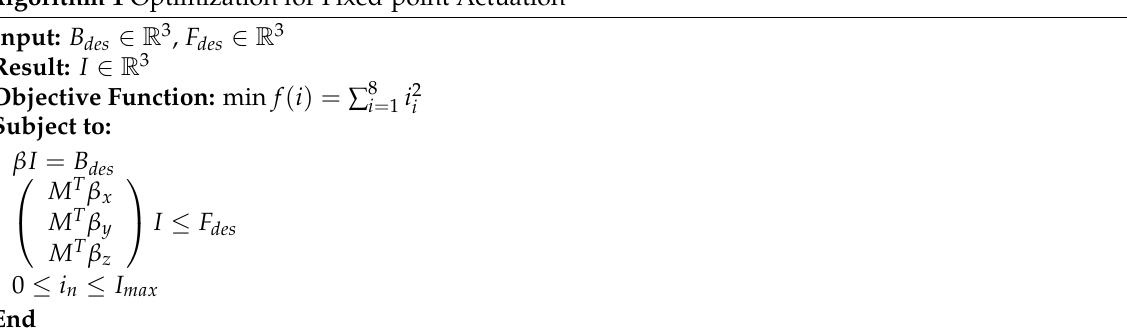
Algorithm 1 Optimization for Fixed-point